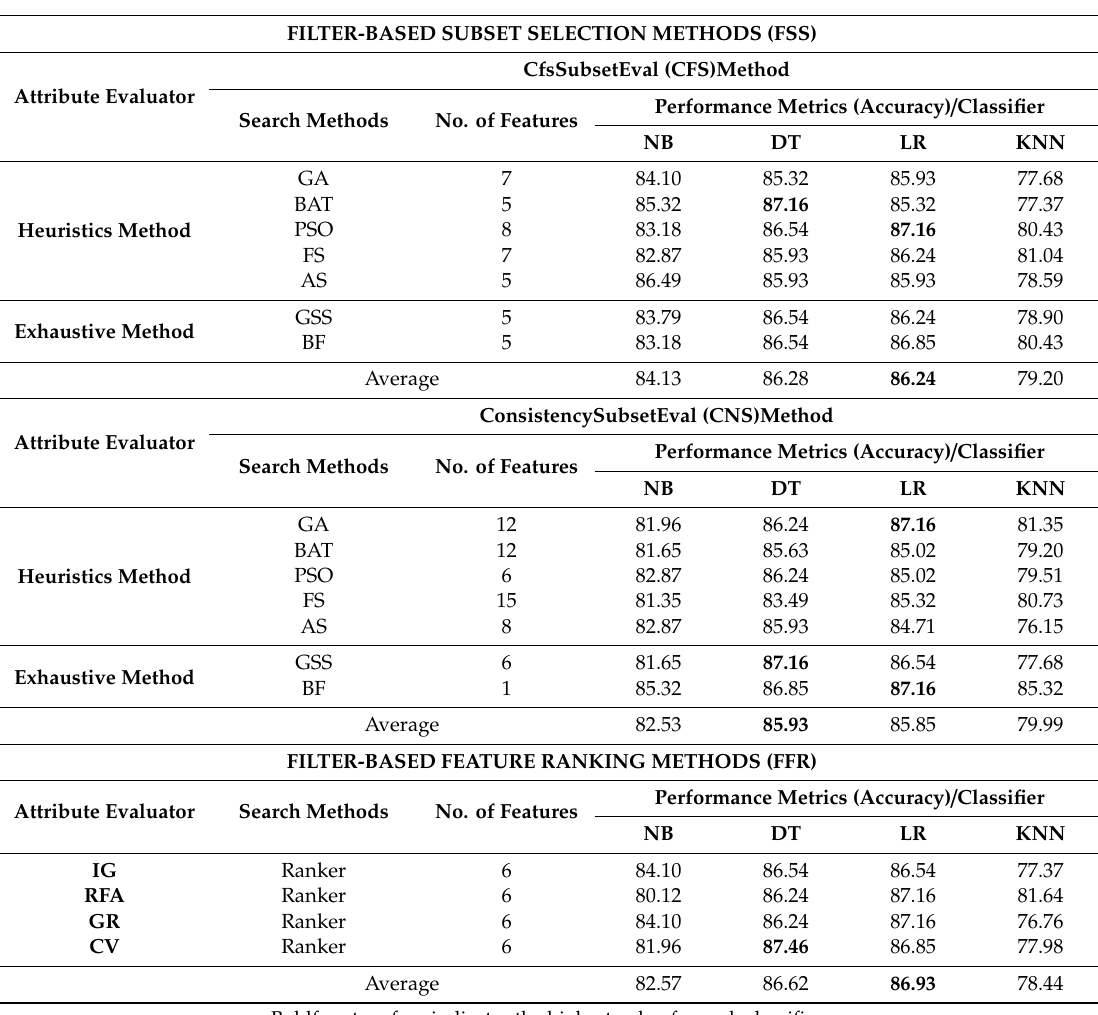
Table 10. Performance Accuracy Values of FS-based Prediction Models on CM1